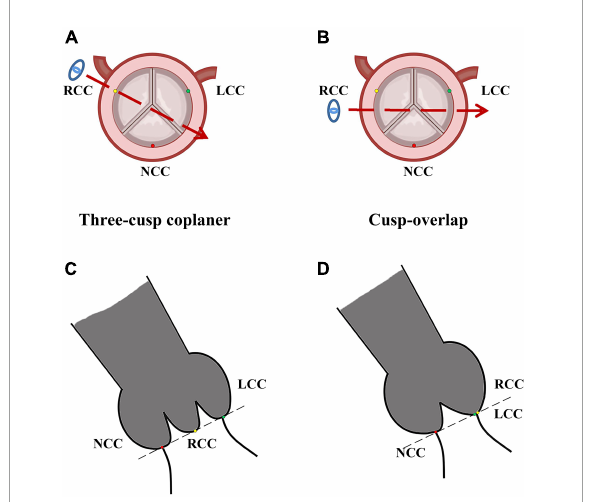
FIGURE1 Image of cusp-overlap projection and three-cusp coplanar view. LCC, left coronary cusp; NCC, non-coronary cusp; RCC, right-coronary cusp. Typical image of standard three-cusp coplanar in pre-operative axial reconstruction (A) and fluoroscopy during TAVR procedure (C) . In standard fluoroscopy, RCC (yellow dot) was located in the middle of NCC (red dot), and LCC (green dot). Panels (B,D) represented images of cusp-overlap projection, where RCC (yellow dot) and LCC (green dot) were overlapped in fluoroscopy. The blue eye and dotted red arrows represented projection direction in